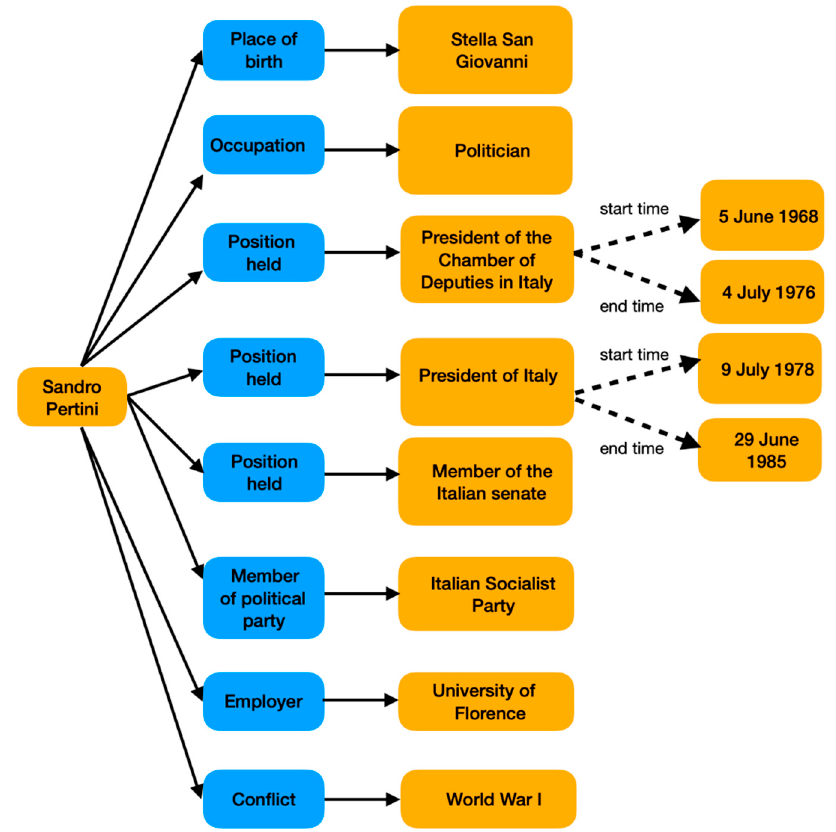
Figure 11. A portion of the network extracted by looking for information about Sandro Pertini in Wikidata. Orange nodes are entities while blue nodes are properties in Wikidata. Dashed arrows represent qualifiers.